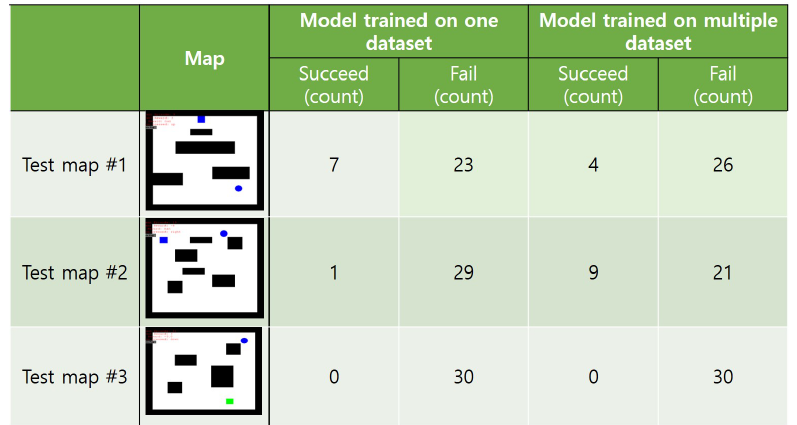
Figure 14. Evaluation results of a DQN